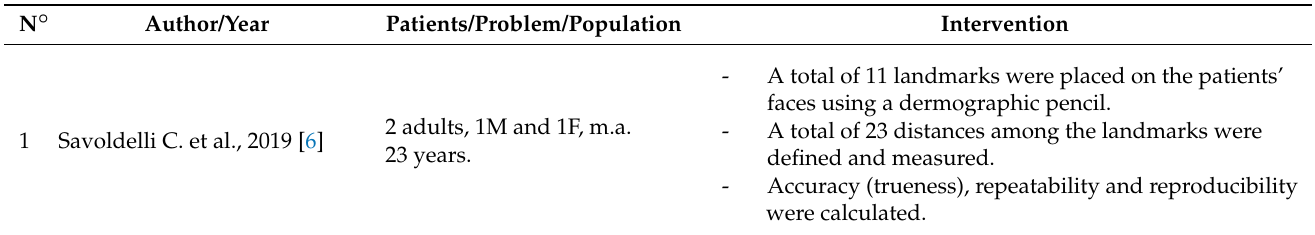
Table 3. Articles validating Canfield’s Vectra H1 portable device. (Original definitions are maintained. Results are re-labeled in italic with definitions according to